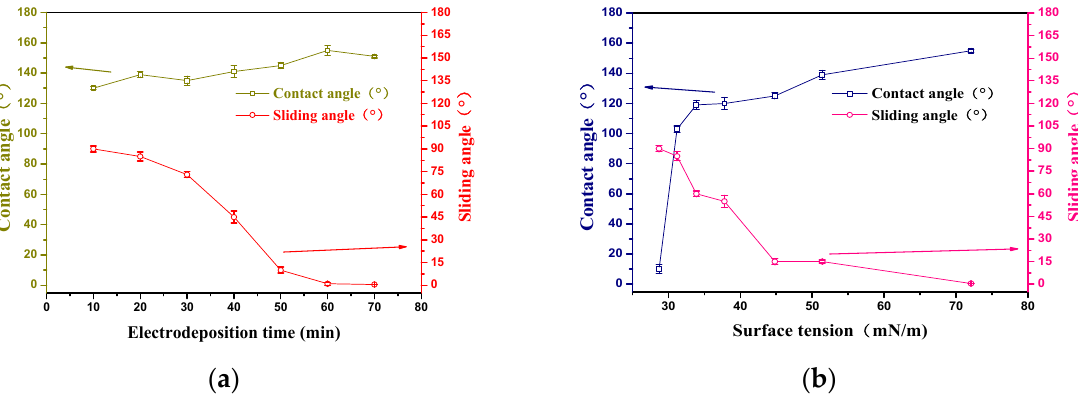
Figure 2. Optimization of electrodeposition time for the fabricated mesh ( a ); Surface wettability for liquid droplets with different surface tension values using the resulted mesh ( b ).